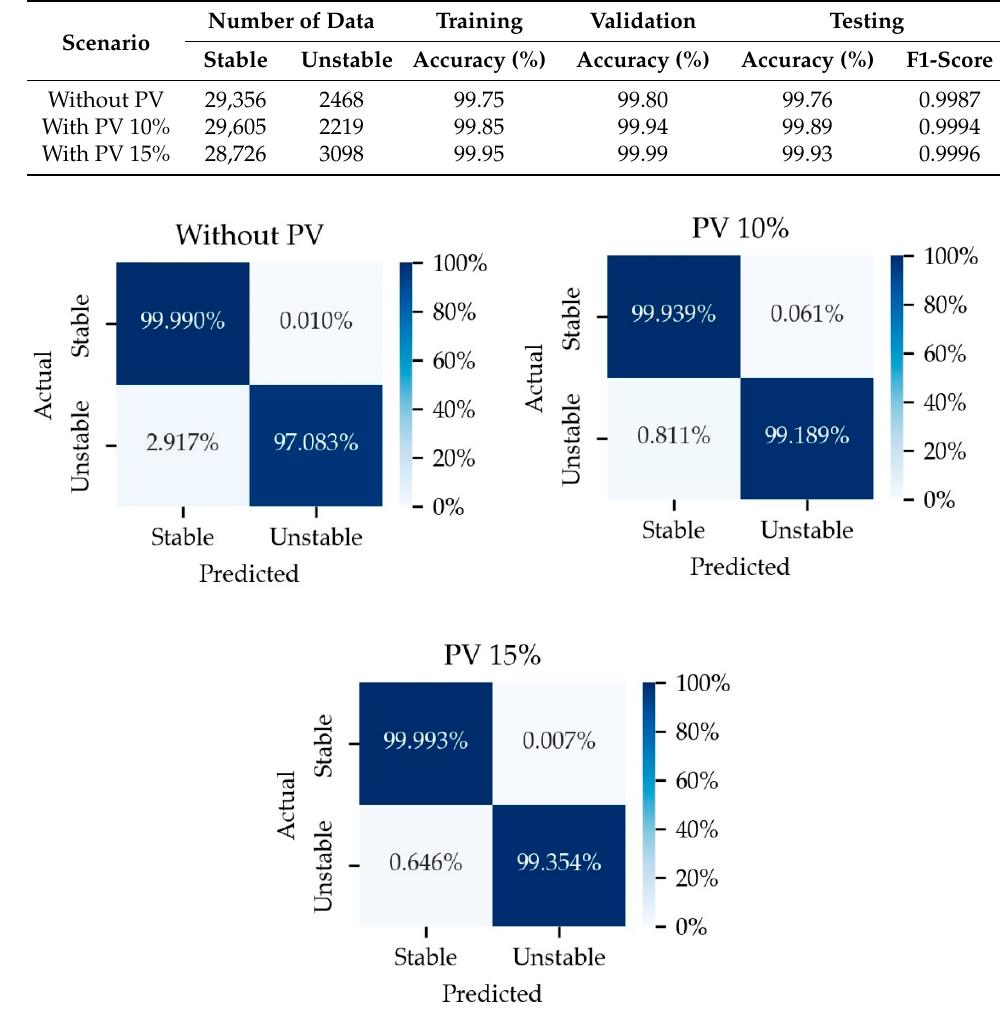
Figure 6. Recapitulation of normalized confusion matrix for PV penetration